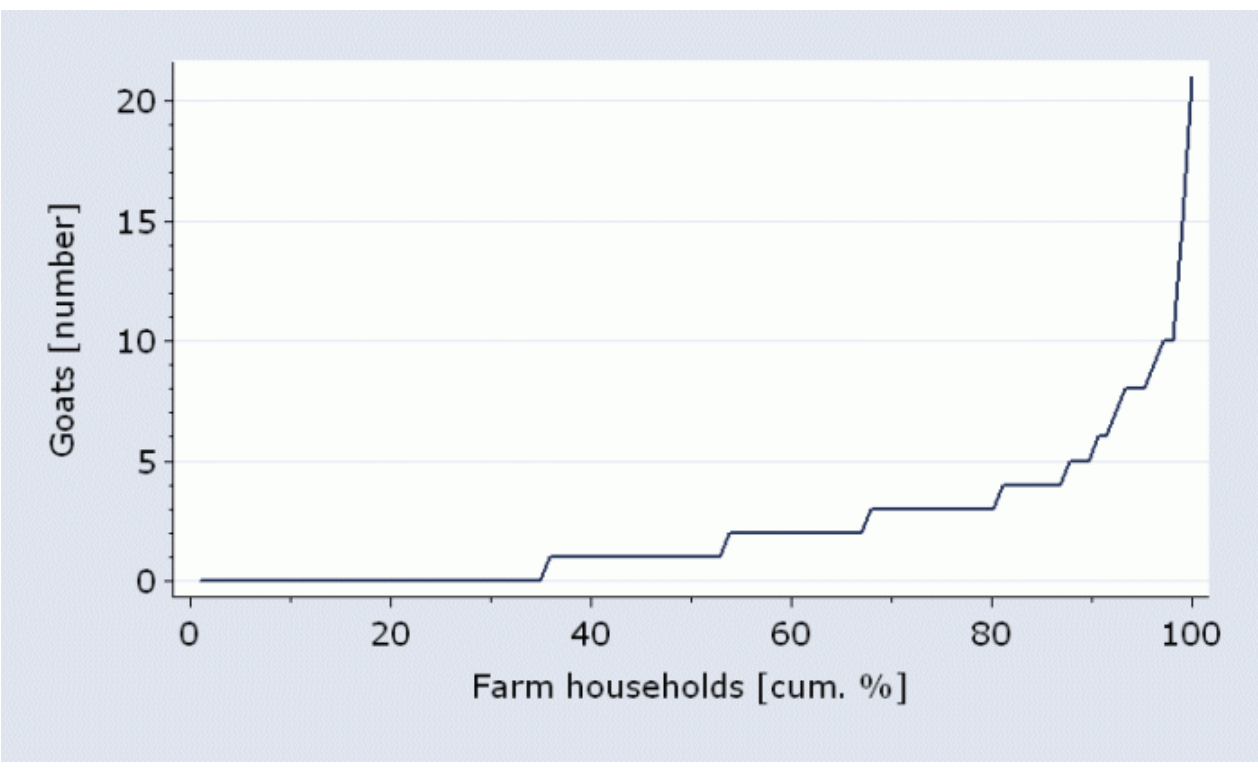
Fig. 3. Empirical cumulative distribution of goats over all households in the